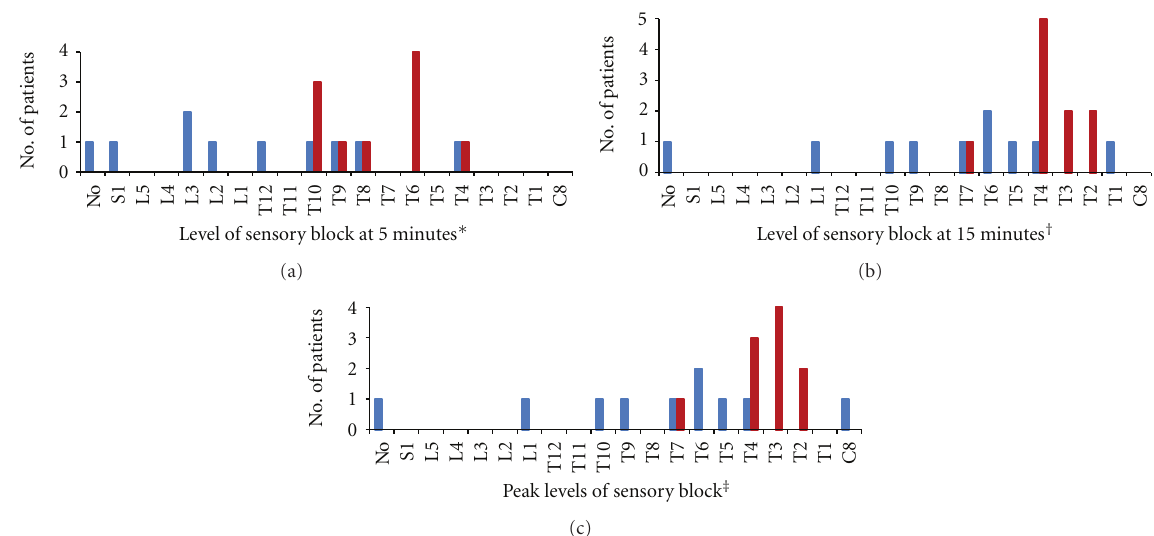
Figure 2: Sensory block levels at 5 and 15 minutes after spinal block, and peak levels of sensory block in patients receiving isobaric (blue bars) or hyperbaric levobupivacaine (red bars). Hyperbaric levobupivacaine reached higher sensory block levels at all periods of time ( ∗ P = 0 . 011, † P = 0 . 027, and ‡ P = 0 . 040, resp.). More patients in hyperbaric group reached T10 or higher at 5 minutes, T4 or higher at 15 minutes, and higher peak levels of sensory block than in isobaric group ( ∗ P = 0 . 011, † P = 0 . 005, and ‡ P = 0 . 005, resp.).